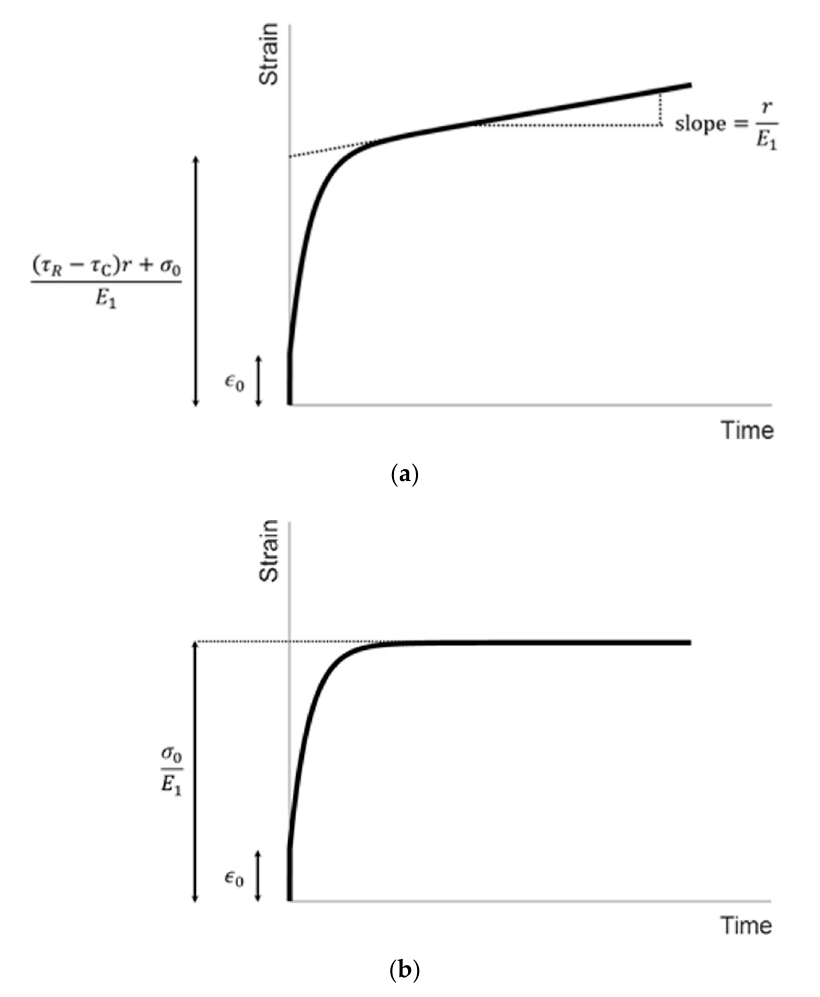
Figure 3. Illustration of the strain responses in the ramp mode ( a ) and creep mode ( b ).